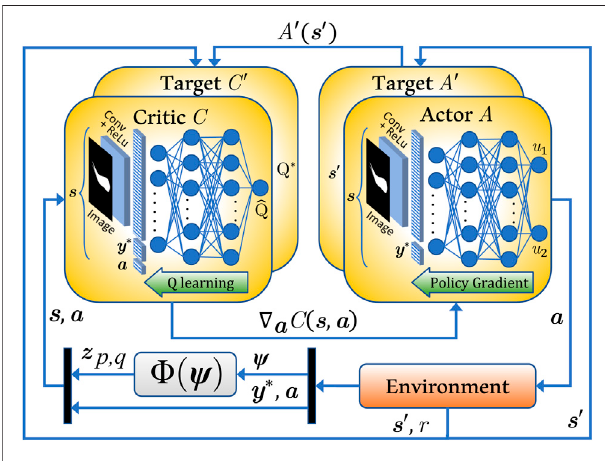
FIGURE 6 | DDPG process chart incorporating image-based observations.